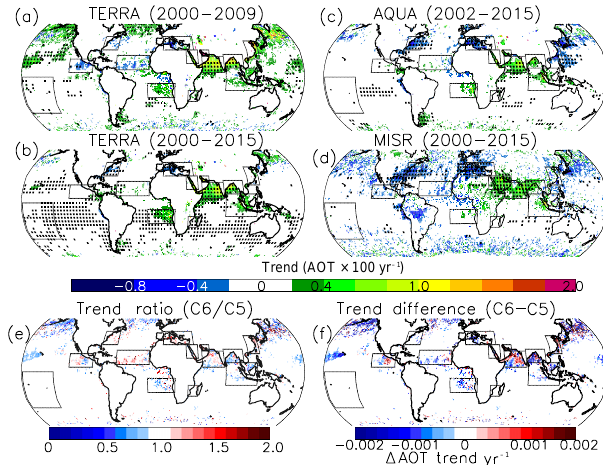
Figure 1. Spatial distribution of trends for (a) over-ocean Terra MODIS DT AOT for 2000–2009, (b) over-ocean Terra MODIS DT AOT for 2000–2015, (c) over-ocean Aqua MODIS DT AOT for 2002–2015, and (d) over-land and ocean Terra MISR AOT for 2000–2015 for every 1 ◦ × 1 ◦ bin. (e) Ratios of MODIS C6 to C5 AOT trends for the study period of 2000–2009 and (f) differences in MODIS C6 to C5 AOT trends for the study period of 2000–2009. Regions with statistically significant trends at a confidence inter- val of 95% are indicated with black dots. Panels (e) and (f) are constructed with the use of grids with AOT trends above or below ± 0.002AOT year − 1 . Also, the leftmost (rightmost) segments of the color bars in panels (e) and (f) represent data points equal to or less (greater) than the values